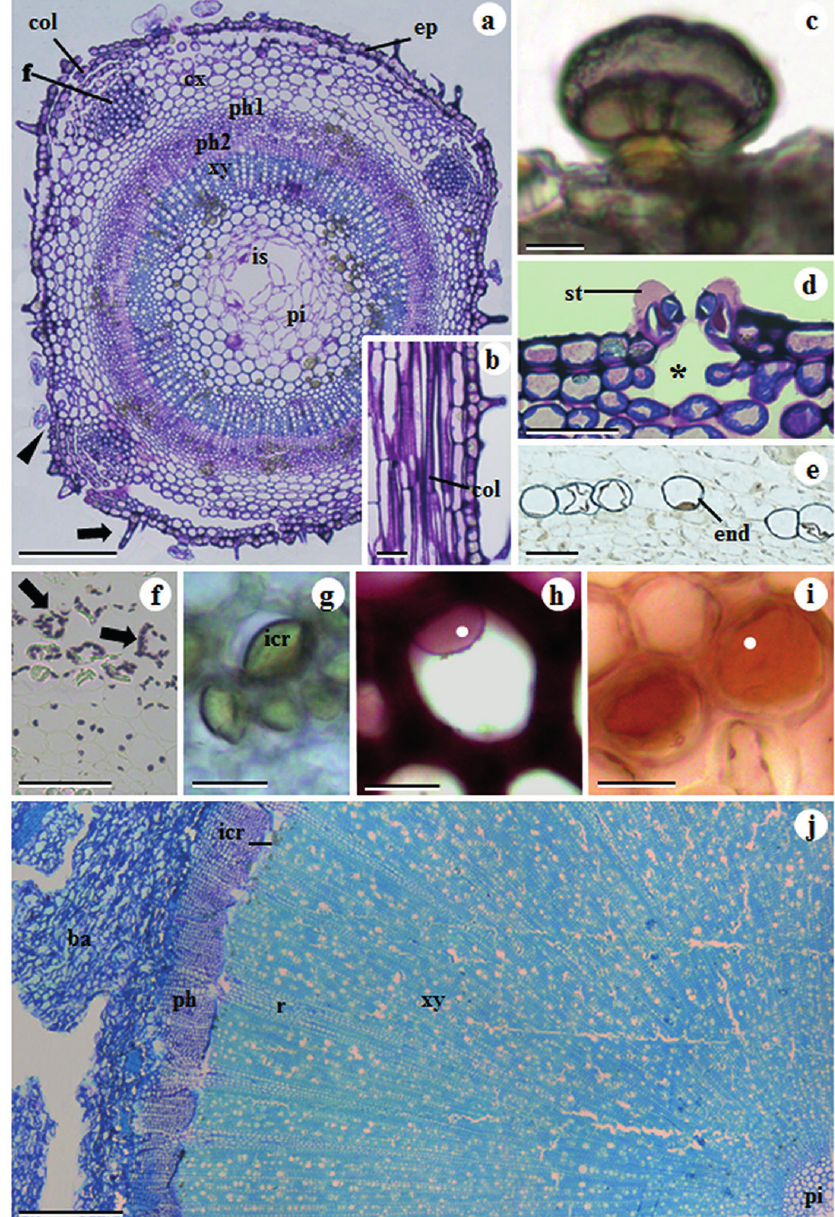
Figure 3 - Structural characterization of Hesperozygis ringens stem. Figures 1a, c-j in transversal sections. Figure 1b in longitudinal section. (a) Glandular trichome (arrow head), non-glandular trichome (arrow), epidermis (ep), collenchyma (col), fiber (f), cortex (cx), primary phloem (ph1), secondary phloem (ph2), xylem (xy), intercellular space (is), pith (pi). (b) Detail of collenchyma (col). (c) Detail of glandular trichome. (d) Detail of stomata (st) and substomatic chamber (asterisk). (e) Detail of endodermis (end) stained by Sudan Black B. (f) Detail of starch (black arrow) in endodermis after reaction with lugol. (g) Detail of inulin crystals (icr). (h) Detail of reddish precipitate (circle) after phloroglucin reaction. (i) Detail of orange precipitate (circle) after phloroglucin reaction. (j) Bark (ba), inulin crystal (icr), phloem (ph), xylem (xy), rays (r) and pith (pi). Scale bars: 20 µm (c, g, h, i and j) ; 50 µm (b, d and f) ; 100 µm (a) ; 500 µm (e)